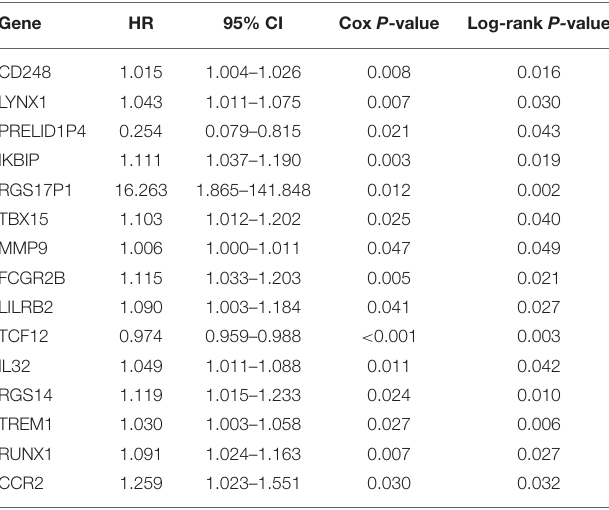
FIGURE 2 | Heatmap and volcano plot of 198 DEIRGs in TCGA-GBM patients. (A) Heatmap of 198 DEIRGs in TCGA-GBM patients. Blue and red indicate the genes of a lower and higher expression. (B) Volcano plot of 198 DEIRGs in TCGA-GBM patients. Blue and red, respectively, represent the significantly downregulated and upregulated genes. The names of genes in the dense regions are hidden. TABLE 1 | The results of the univariate Cox regression